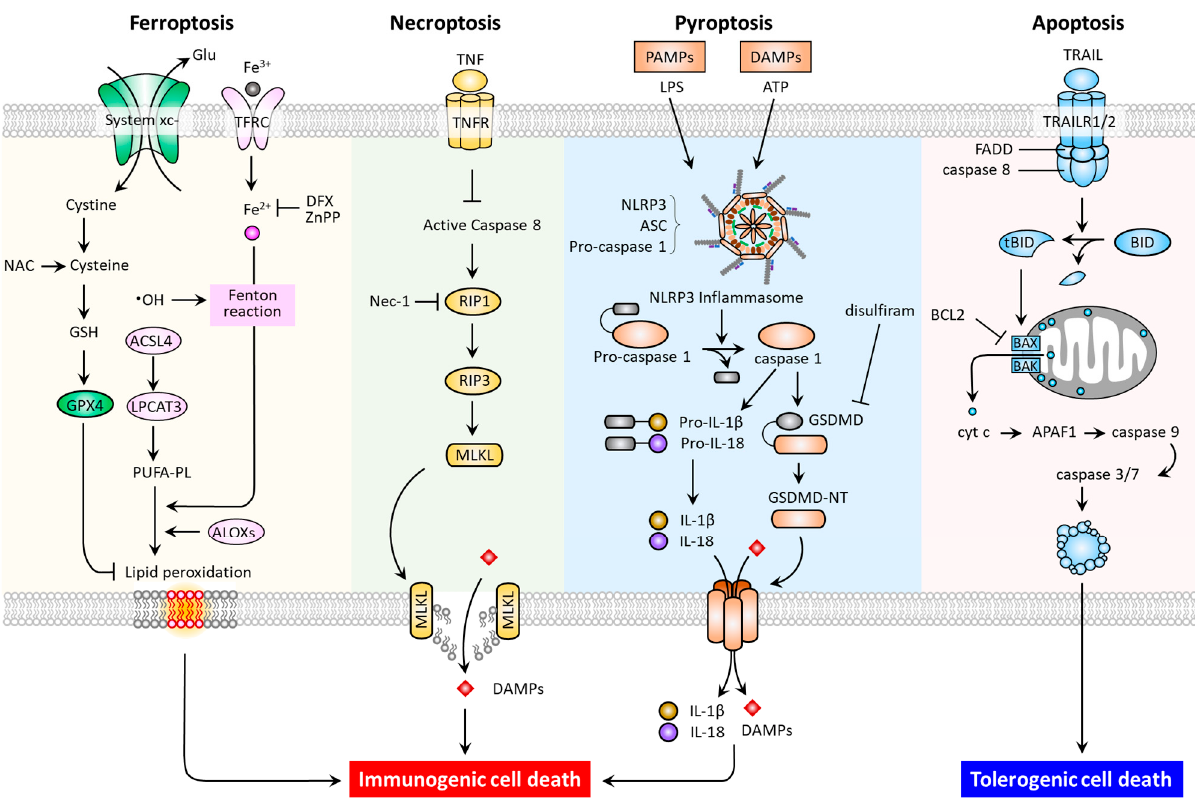
Figure 1. Molecular pathways and immunogenic properties of ferroptosis, necroptosis, pyroptosis, and apoptosis. ACSL4, acyl-CoA synthetase long chain family member 4; ALOXs, arachidonate lipoxygenases; ASC, apoptosis-associated speck-like protein containing a CARD (ASC); LPCAT3, lysophosphatidylcholine acyltransferase 3; TFRC, transferrin receptor; APAF-1, apoptotic peptidase activating factor 1; BAK, Bcl-2 homologous antagonist/killer; BAX, Bcl-2-associated X; BCL2, B-cell lymphoma 2; BID, BH3 interacting domain death agonist; DFX, deferoxamine; tBID, truncated BH3 interacting domain death agonist; FADD, Fas-associated protein with death domain; GSDMD, gasdermin D; MLKL, mixed lineage kinase domain-like pseudokinase; Nec-1, necrostatin-1; NLRP3, Nod-like receptor 3; RIP1, receptor-interacting protein kinase 1; RIP3, receptor-interacting protein kinase 3; TNF, tumor necrosis factor; TNFR, tumor necrosis factor receptor; TRAIL, tumor necrosis factor-related apoptosis-inducing ligand; TRAILR1, tumor necrosis factor-related apoptosis-inducing ligand receptor